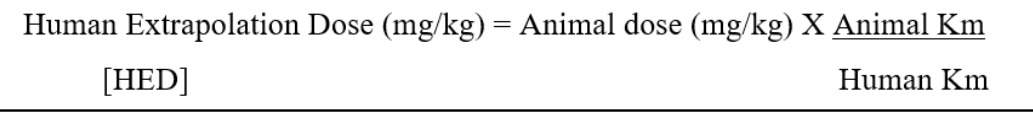
Figure 3. Formula for dose translation from animal to human based on Body Surface Area (BSA). Source: [113].